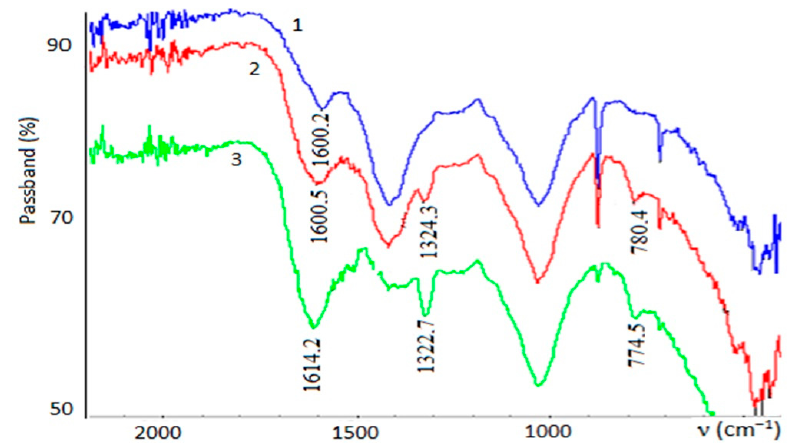
Figure 4. Infrared (IR) spectra of composites: 1—initial iron-containing composite; 2—iron-containing composite after the sorption of H 2 C 2 O 4 ; 3—iron-containing composite after the degradation of H 2 C 2 O 4 using the Ruff-Fenton system.